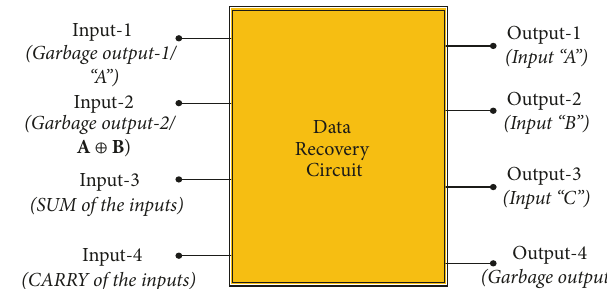
Figure 13: Block diagram of data recovery circuit of the proposed full